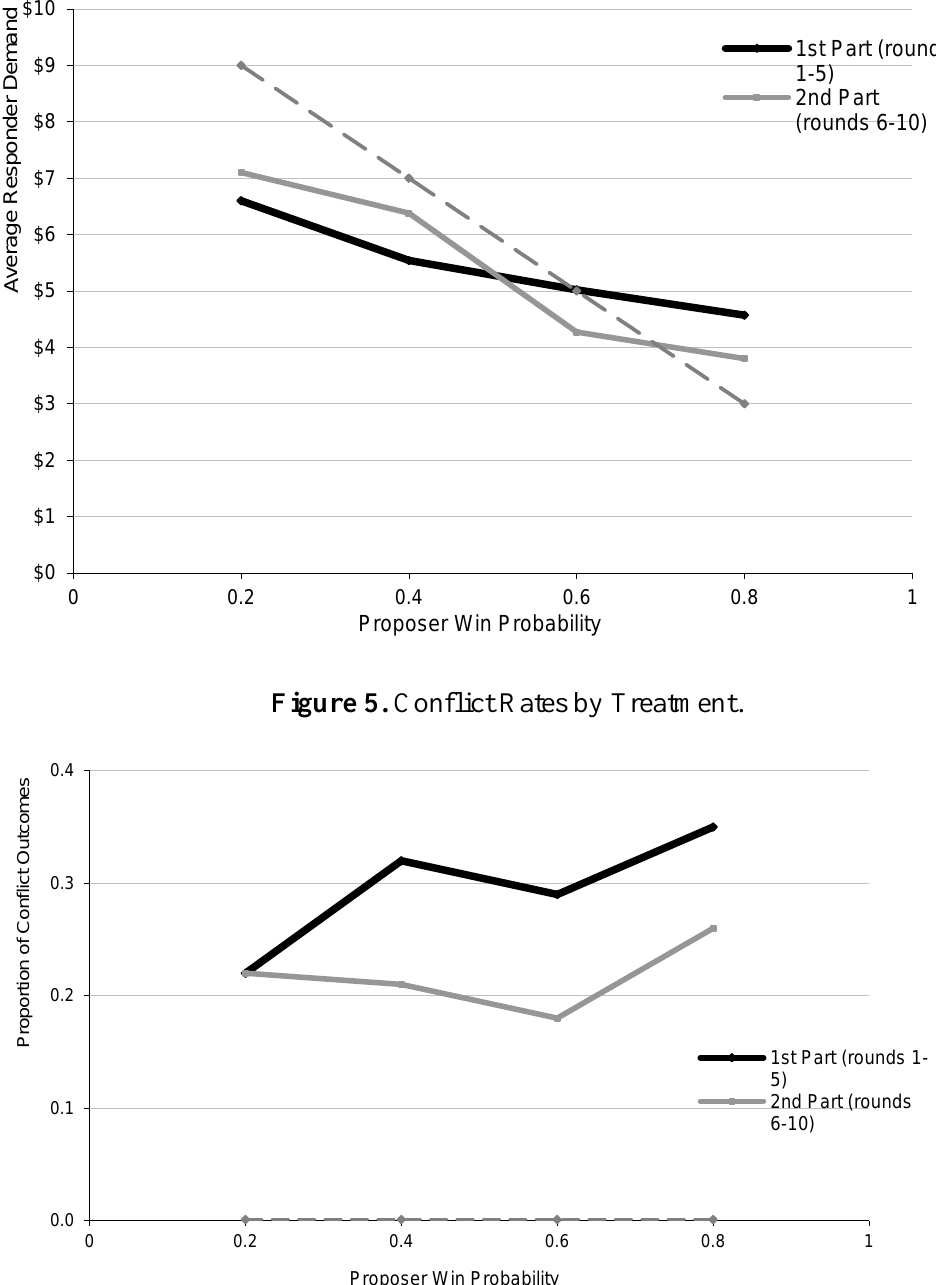
Figure 4. Average Responder Demand by Treatment.